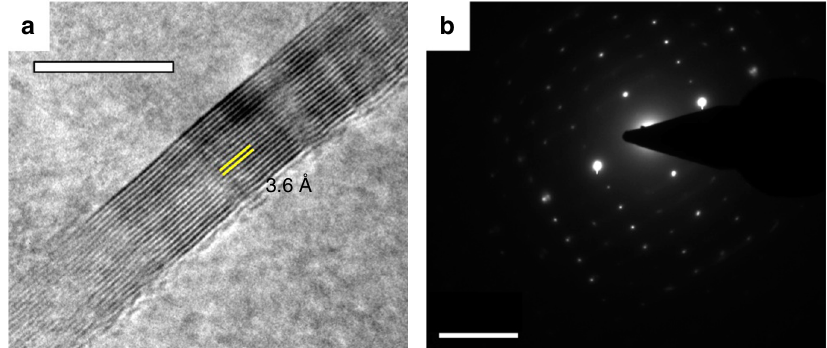
Fig. 4 Transmission electron microscopic analysis of Mg-CP fi bres. a High-resolution TEM image of Mg-CP fi bres. Scale bar, 10 nm. b Single-crystalline SAED pattern obtained from the agglomerates of Mg-CP fi bres. Scale bar, 5 nm − Zn 2 (Olz) (Fig. 3d). Whereas the WAXS pattern of AzSA matches (Fig. 3d) 34 . The diameter determined from WAXS is in good agreement with the distance of ~24 Å, reported for Zn 2 + -osala- well with a layered structure similar to its ammonium salt zine-based MOF [ Zn 2 (Olz) ] (Fig. 3d), which is isostructural to its (Supplementary Fig. 3). Transmission electron microscopic magnesium anlogue 35 . The distances between the parallel and images of Mg-CP fi bres (Fig. 4a and Supplementary Fig. 4) antiparallel organic struts of AzSA were estimated to be 6.8 and revealed highly crystalline nature of a closely packed and ordered 3.4 Å, respectively, by comparing with the crystal structure of ( d = 3.6 Å) structure corresponding to a columnar hexagonal